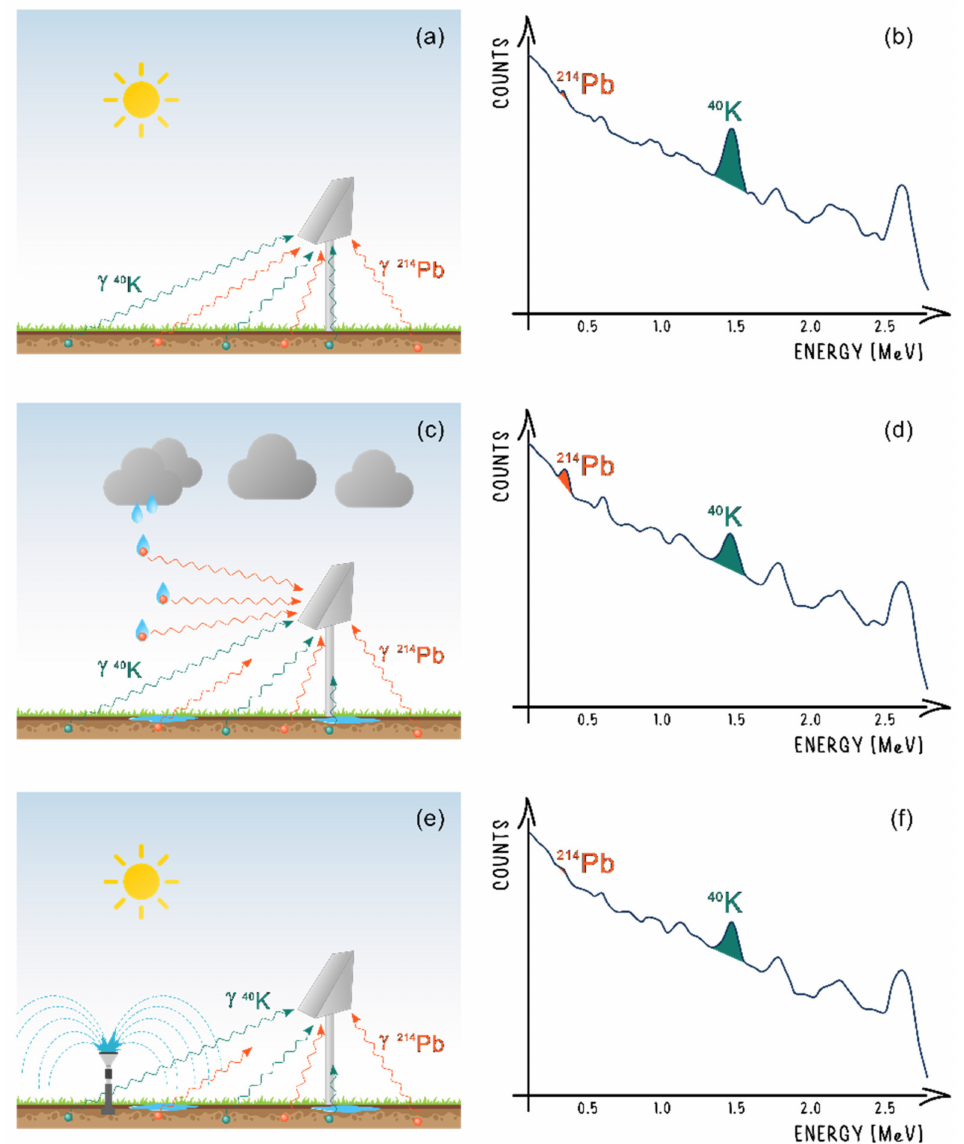
Figure 1. Drawings of the conditions under which the gamma spectra are recorded by the PGRS station ( a , c , e ) and of their respective gamma spectra ( b , d , f ). When no precipitated water is present on the ground ( a ), we can see the corresponding spectrum with the photopeaks of 40 K and 214 Pb highlighted ( b ). During a rain event ( c ), a decrease in the 40 K gamma signal and an increase in the 214 Pb photopeak ( d ) are recorded. In the case of an irrigation ( e ), a decrease in both 40 K and 214 Pb gamma signals can be observed, due to the shielding effect of the water layer on the ground ( f